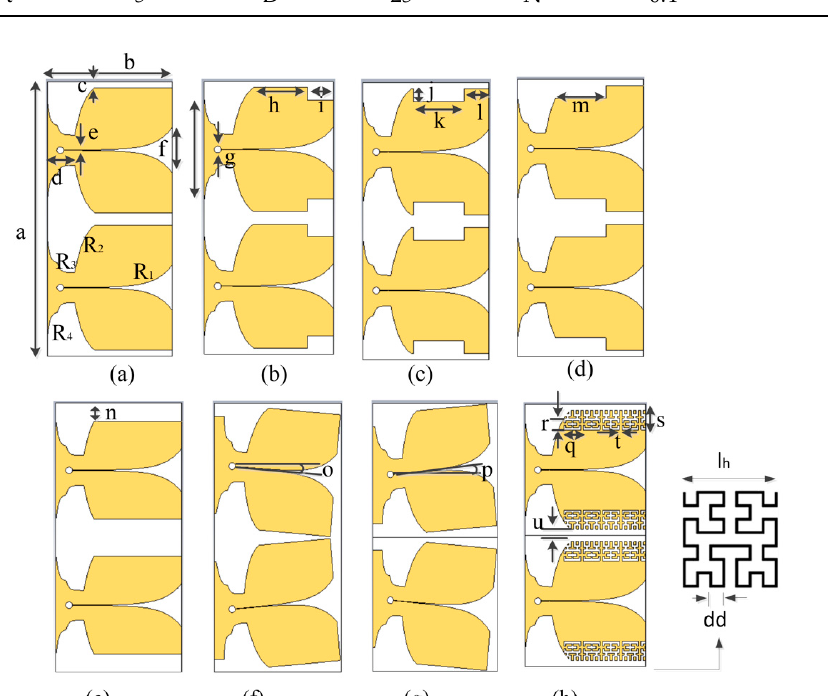
Figure 2c,d show the vertical and horizontal wave slots. The Constant of the wavy slot in Equation (3) is B 1 = 2, B 2 = 1, B 3 = 1, B 4 = 5, and B 5 = 36. The depth of the wave, the number of waves, and the length of the wave slot can all be modified by changing the value of B n [48].